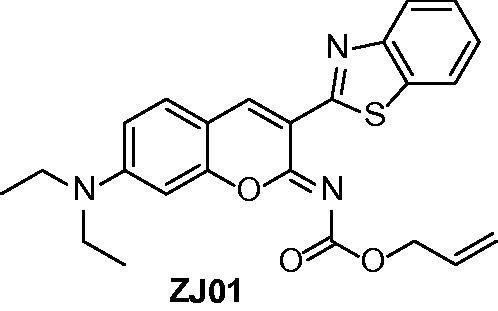
Structure of ZJ01.